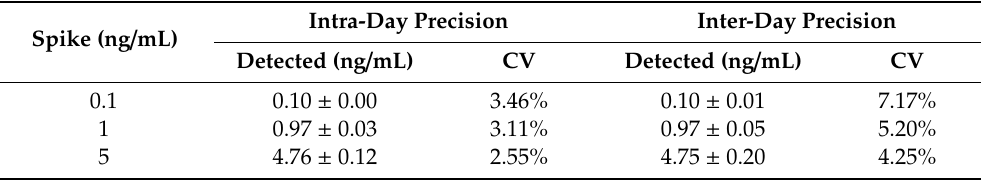
Table 1. Results of precision evaluation.